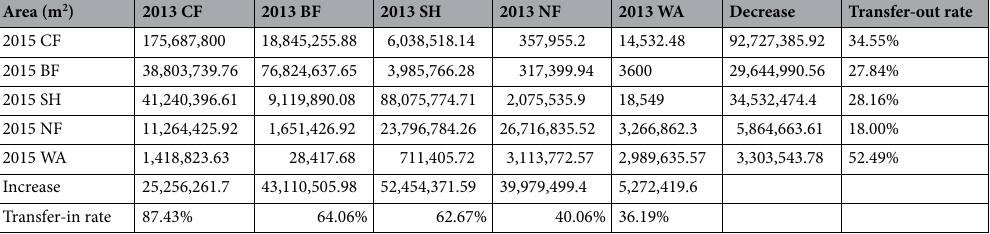
Table 3. Land cover area transfer data between 2013 and